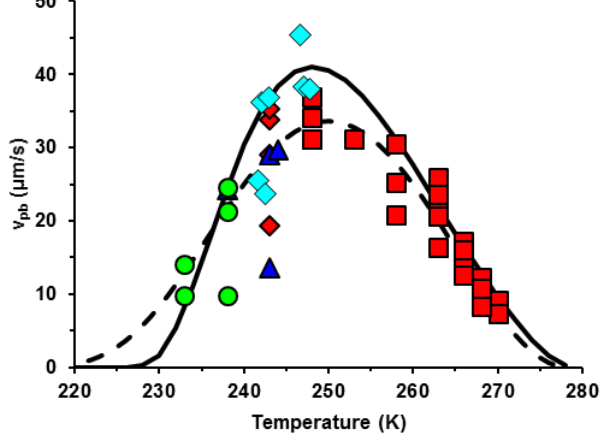
Figure 8. Temperature dependence of the velocity of the phase boundary, v pb (T), for the crystallization of the R = 3 hydrate of zinc chloride. DSC experiments are represented as the red squares (pans) and diamonds (capillaries), TtXRD experiments as blue triangles (bulk analysis), and TtND as green circles, compared with physically measured v pb from video images (cyan diamonds). The solid line represents the best fit to the maximum v pb ’s observed for each T iso , and dashed line is fit to all data, based on transition zone theory; the neutron D 2 O data are excluded from the fits because of the likely KIE.